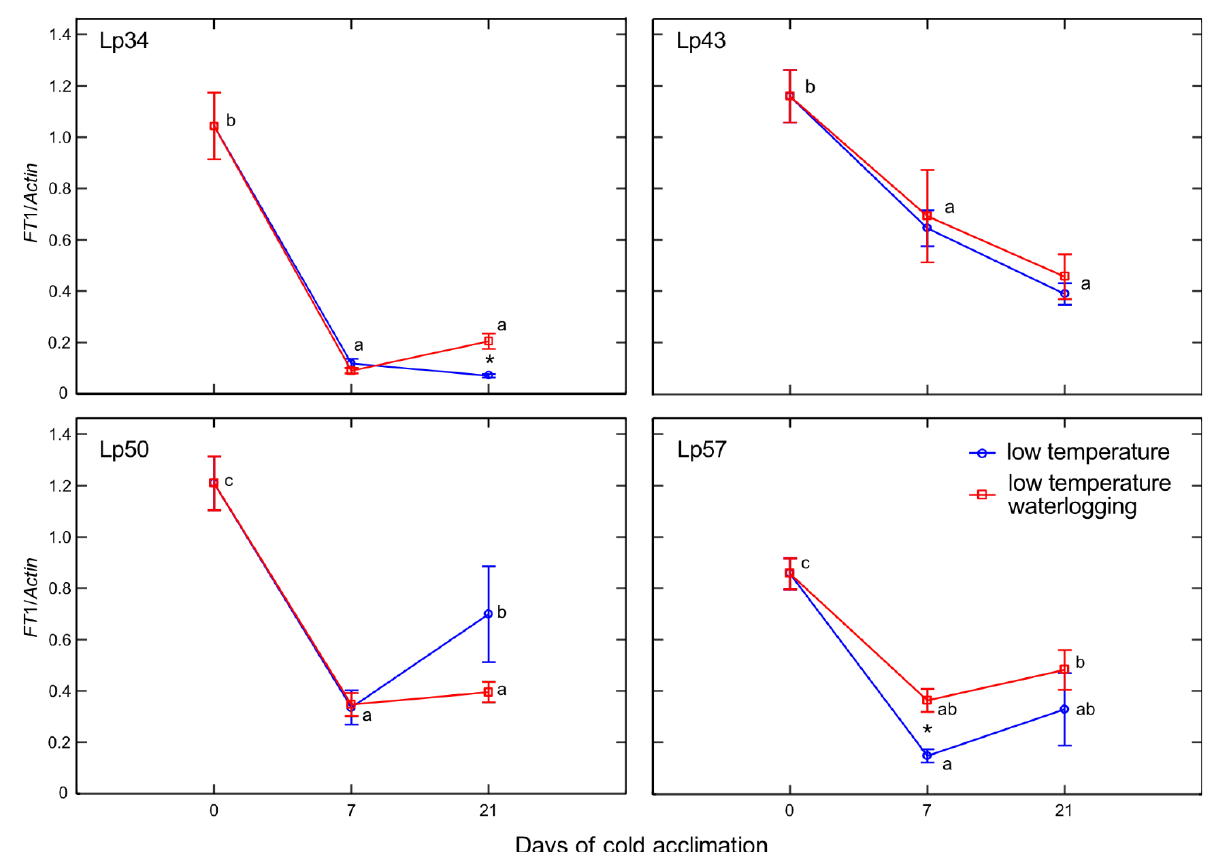
Figure 12. Relative transcript level of FT1 of cold-acclimated Lolium perenne genotypes. Four genotypes (Lp34, Lp43, Lp50, and Lp57) were tested. The transcript level was calculated using Actin as a reference gene. The results are means ( n = 4), error bars indicate the standard error. Asterisks indicate means that differ significantly between waterlogged and control plants according to one-way ANOVA ( p < 0.05). Different lower-case letters indicate means that are statistically different according to Duncan’s multiple range test ( p < 0.05).